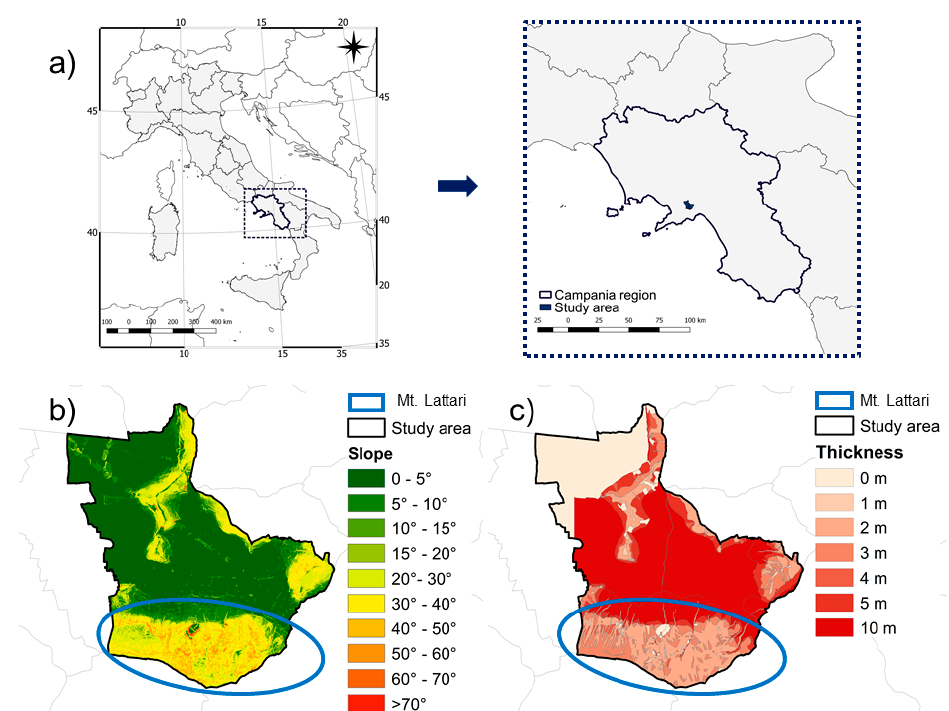
Figure 1. Localization and geomorphological context of the study area: ( a ) national and regional frameworks (Campania region in Southern Italy); ( b ) slope map; ( c ) thickness map.